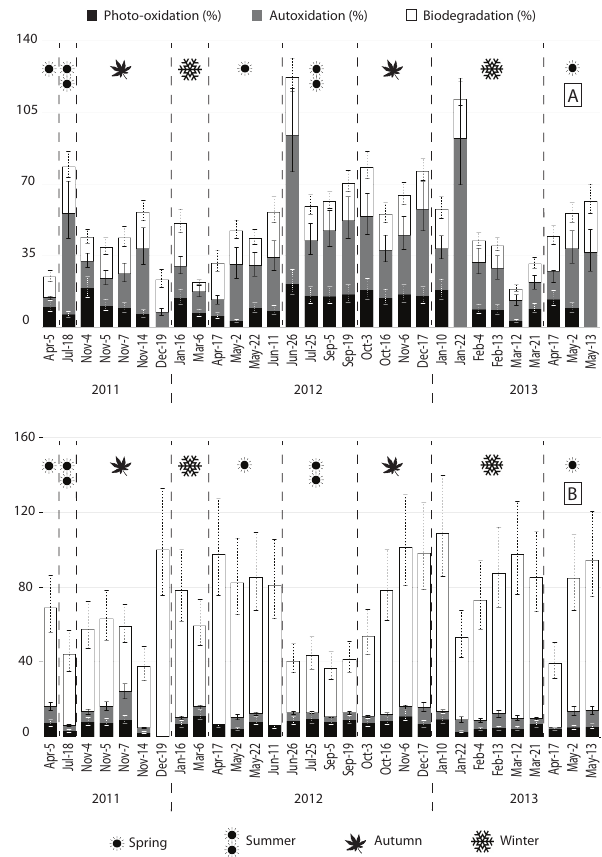
Figure 5. Biotic and abiotic degradation of sitosterol (a) and choles- terol (b) in the different samples. Full error shown here incorporates the 14% analytical standard error estimated for lipid quantification for all terms of the equations used. Sitosterol and cholesterol clearly have very different degradation